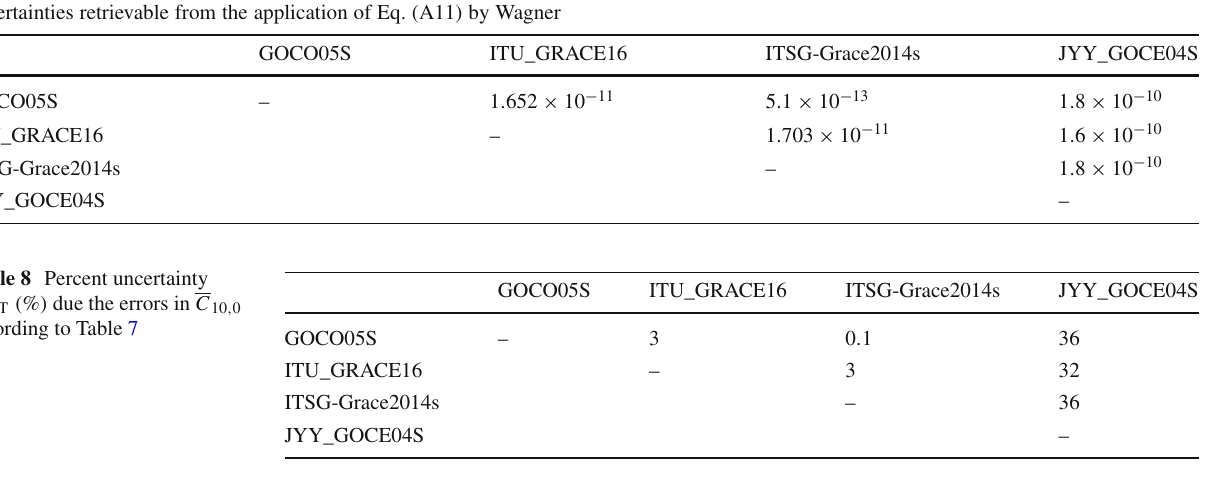
and McAdoo [14] to the sigma of the model to be tested by contrasting it to a formally superior one according to the method of such authors